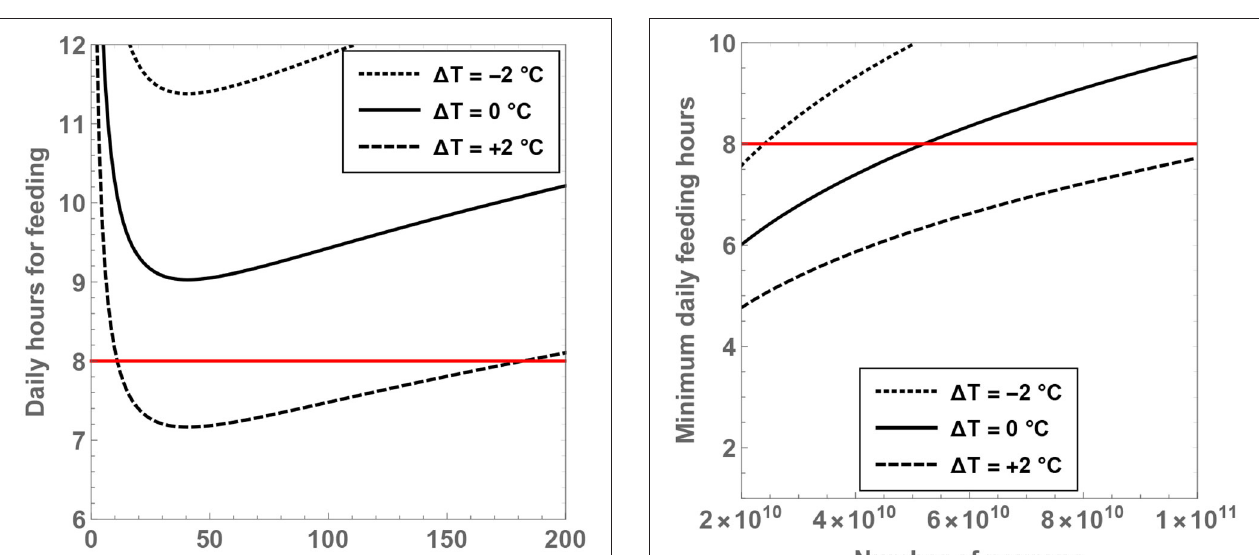
FIGURE 3 | The maximal number of neurons (Left) and the associated body mass (Right) are shown as a function of the number of hours per day spent on feeding. The dotted, unbroken, and dashed curves correspond to body temperatures that differ from present-day humans by − 2, 0, and + 2 ◦ C; the equivalent body temperatures are 35, 37, and 39 ◦ C, respectively. The horizontal red line depicts the neuron number (Left) and mass (Right) for H. sapiens .